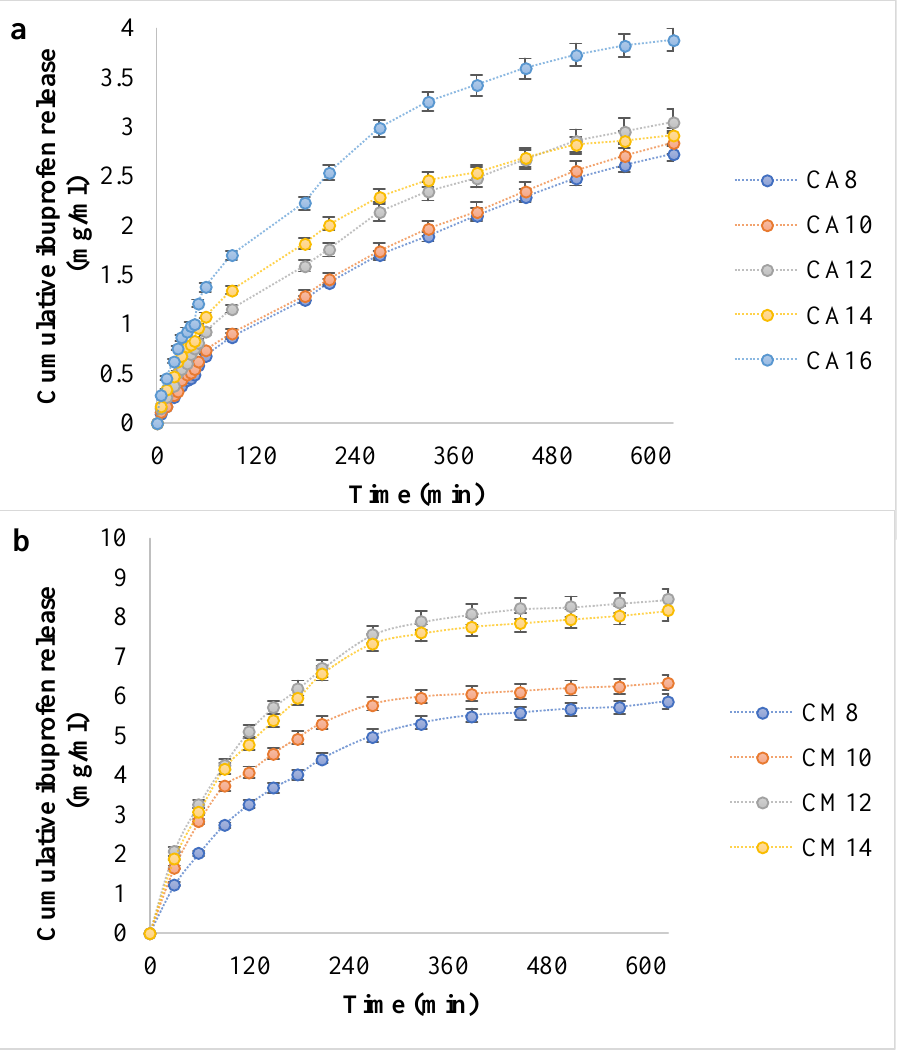
Figure 6. The in vitro ibuprofen release kinetic data ( a , b